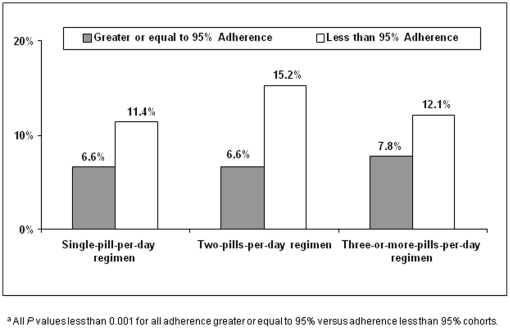
Frequency of Hospitalizations, by Cohorta.